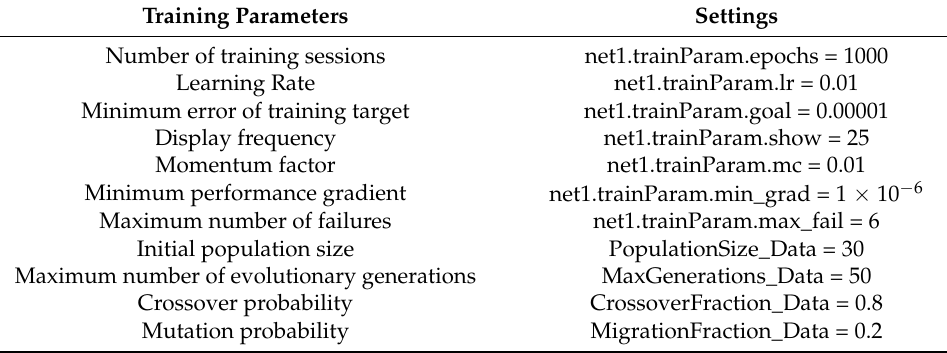
Table 3. Hyperparameter setting of the model.